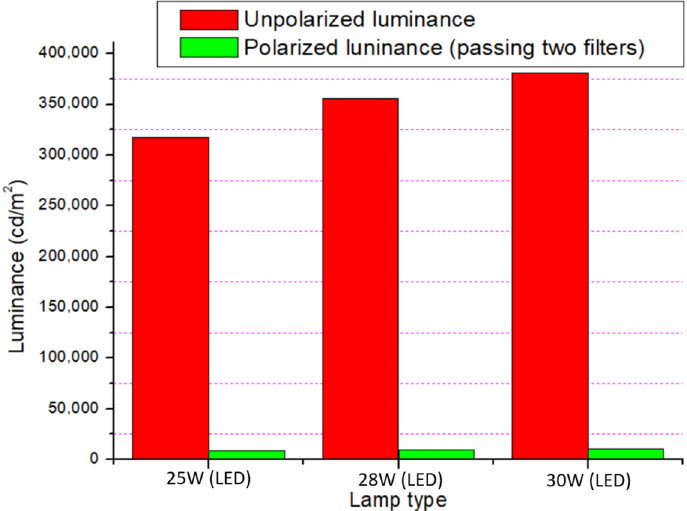
Figure 7. Luminance measurements of LED headlights with different powers (25 W, 28 W, and 30 W) after the light passed through both the polarizing filter and polarizing flip plate.